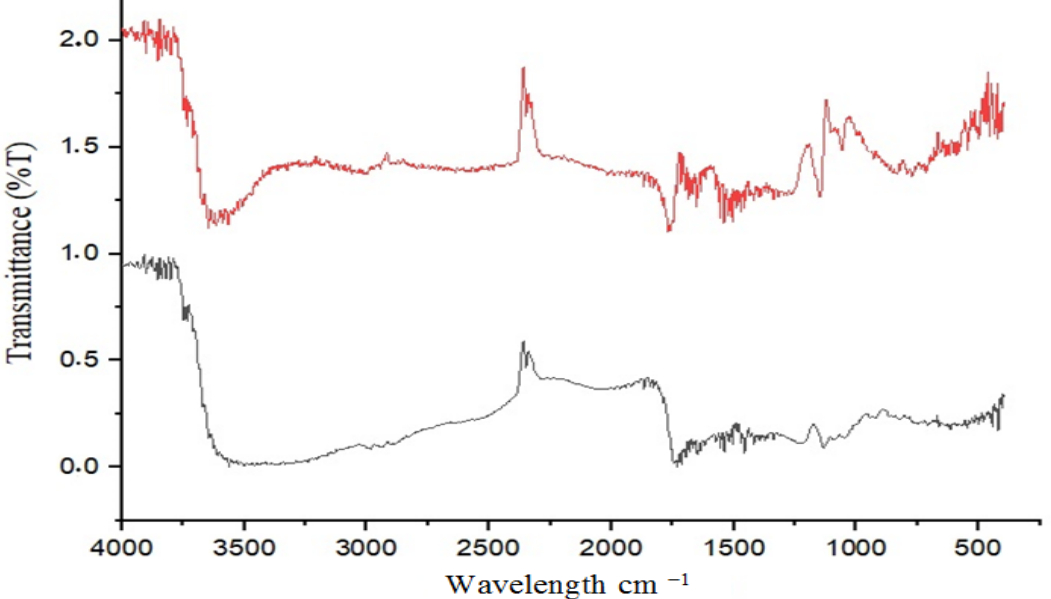
Figure 8. Comparison between extracted chitosan and commercial chitosan using FT-IR tools.